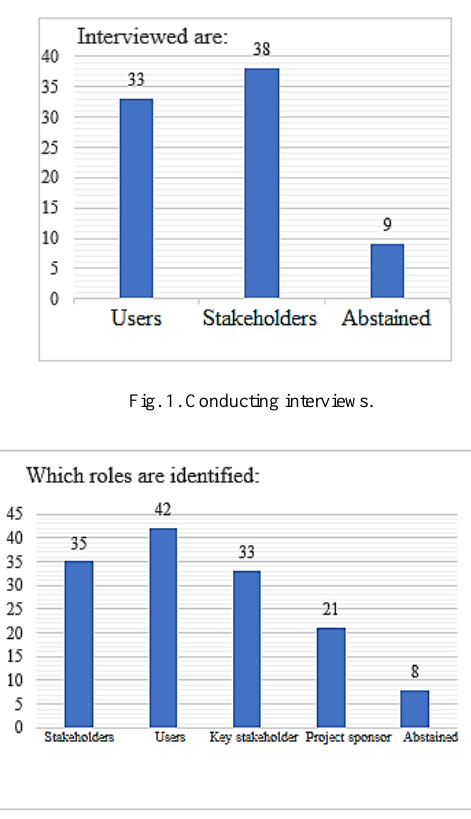
Fig. 2. Stakeholder and/or user